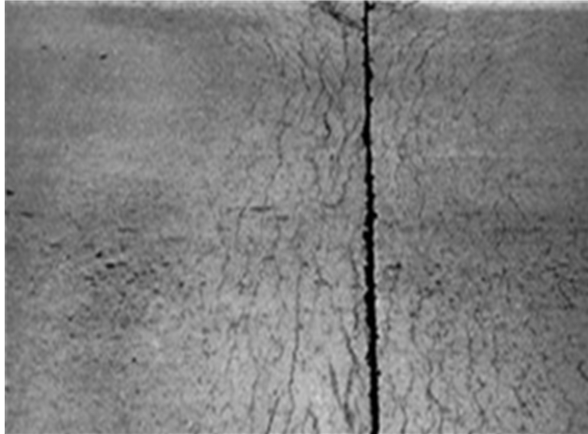
Figure 1: Fracture on the edge of concrete slab in Vietnam